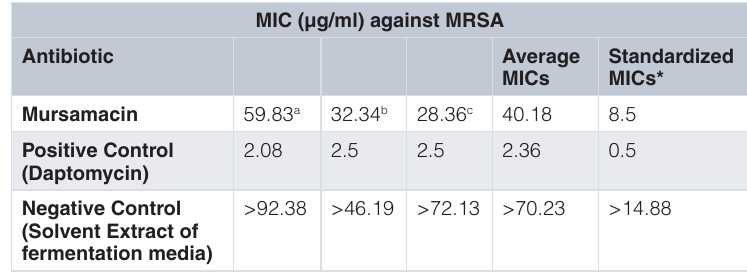
Table 1. MICs of mursamacin against methicillin-resistant S. aureus.